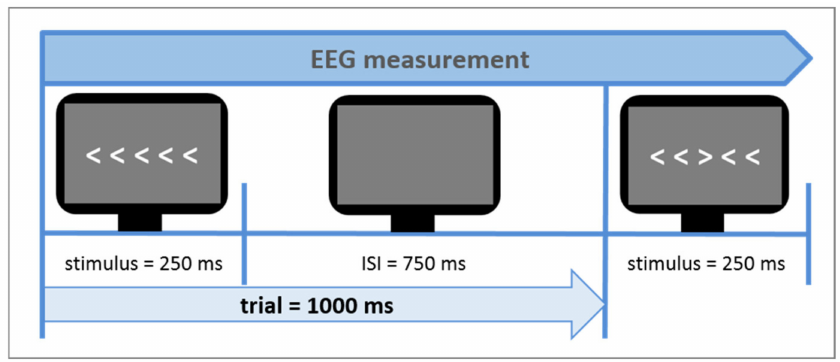
Figure 4. Trial sequence of the flanker